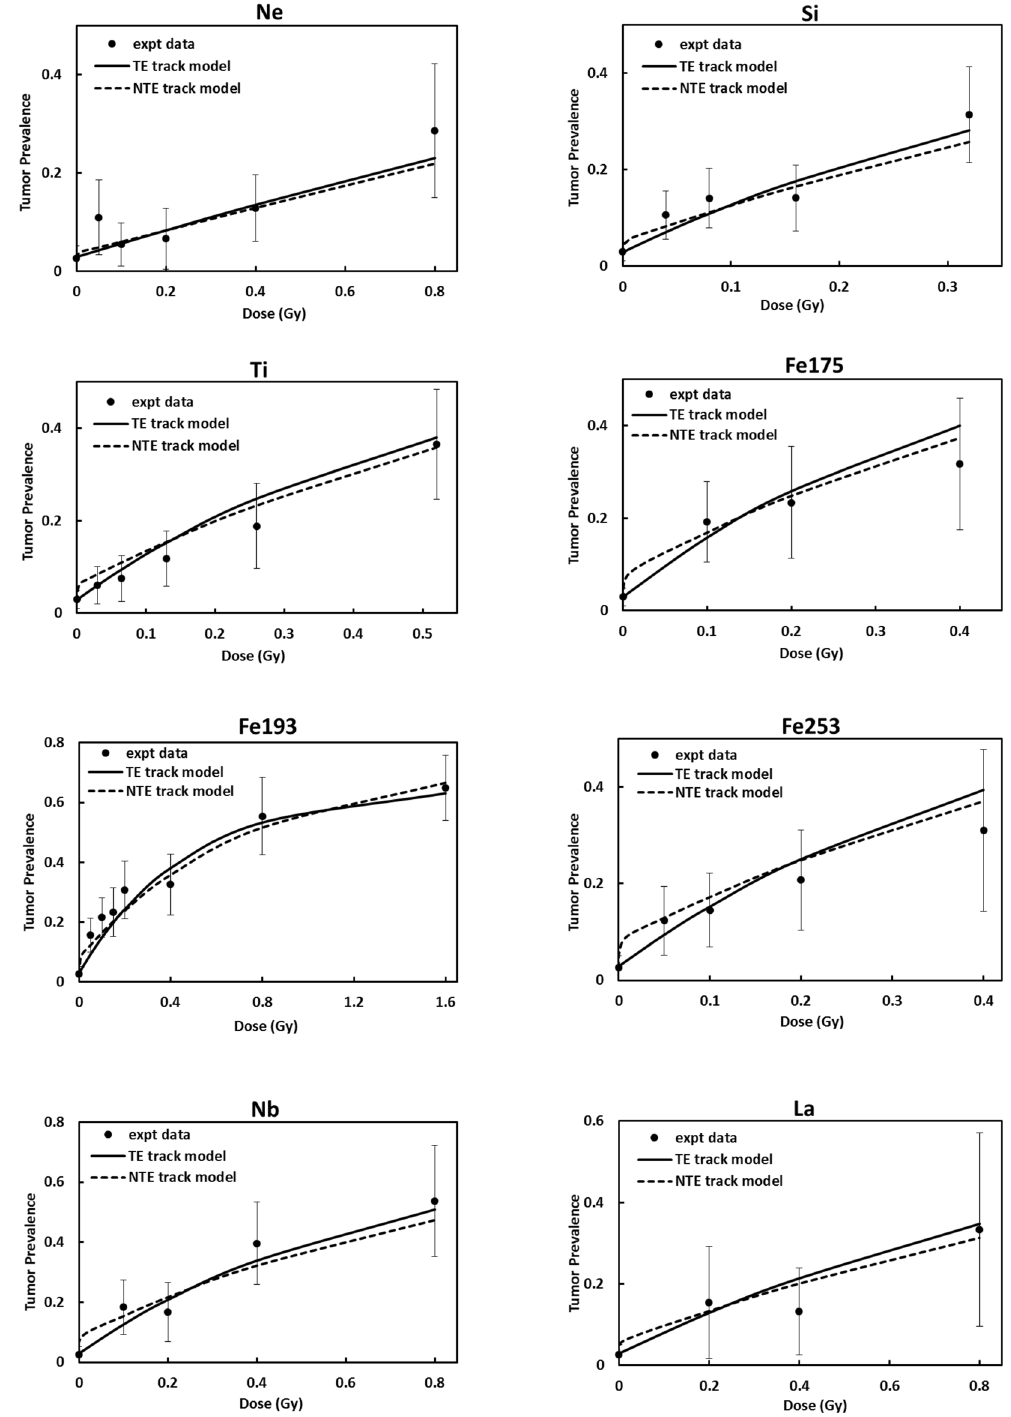
Figure 1. Comparison of TE and NTE models for Ne, Si, Ti, Fe, Nb and La beams to the experiments of Alpen et al . 12, 13 and Chang et al . 14 , respectively for the dose response for Harderian gland tumor prevalence. Error bars represent standard errors in the